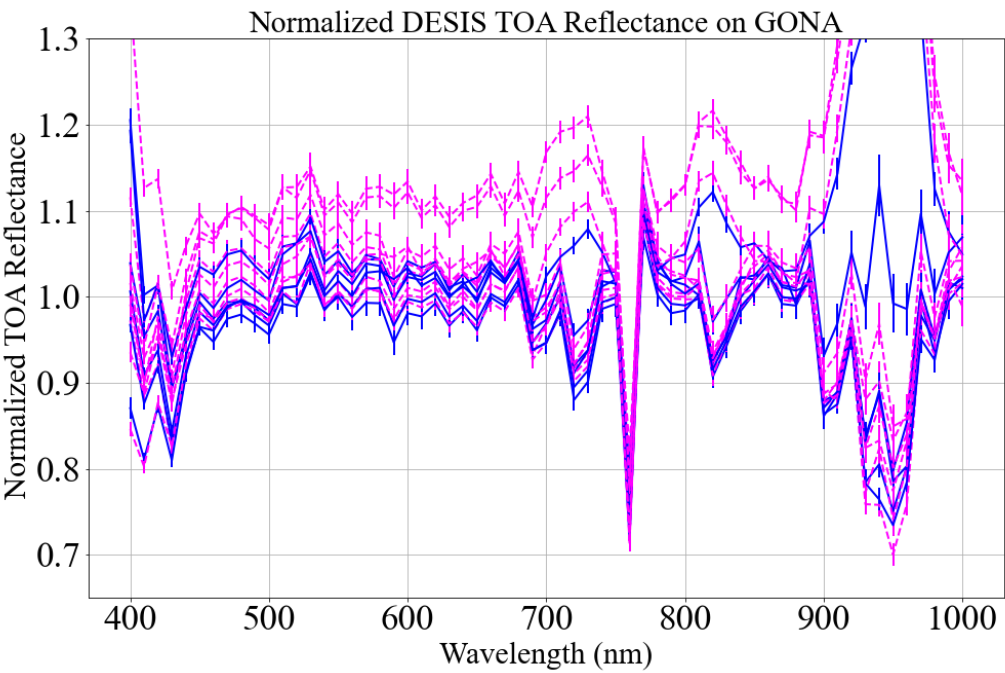
Figure 20. Mean of normalized DESIS TOA reflectance on GONA. Blue and magenta curves represent spectra from de- scending and ascending mode acquisitions, respectively.